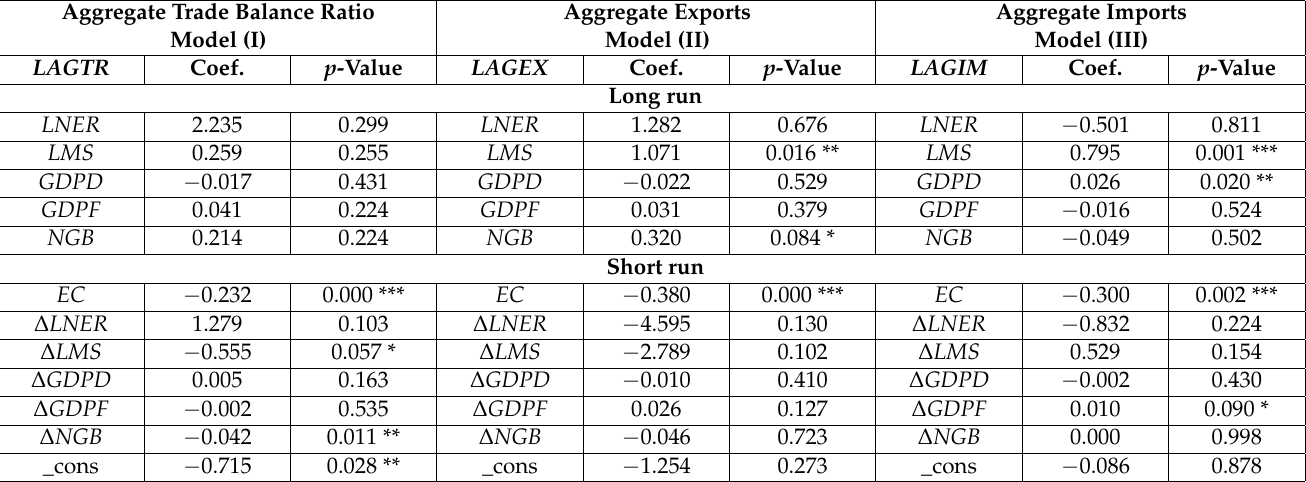
Table A2. The determinants of T&T’s aggregate trade 1991–2019 using DFE.